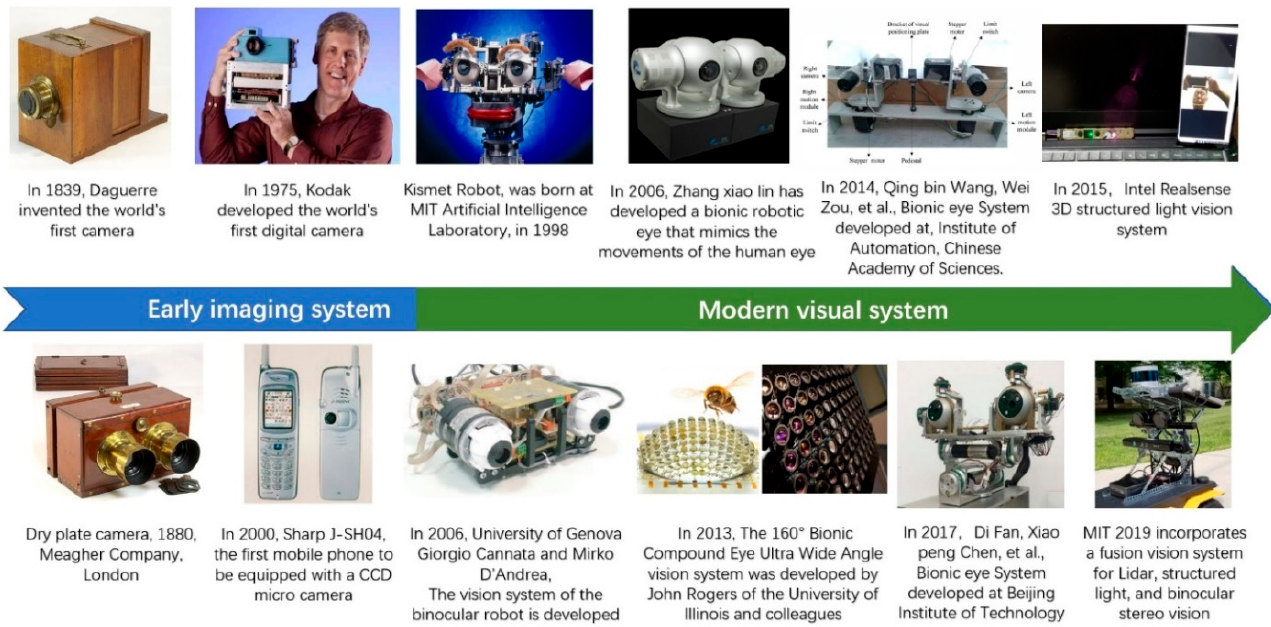
Figure 5. The development of vision equipment and bionic vision technology.